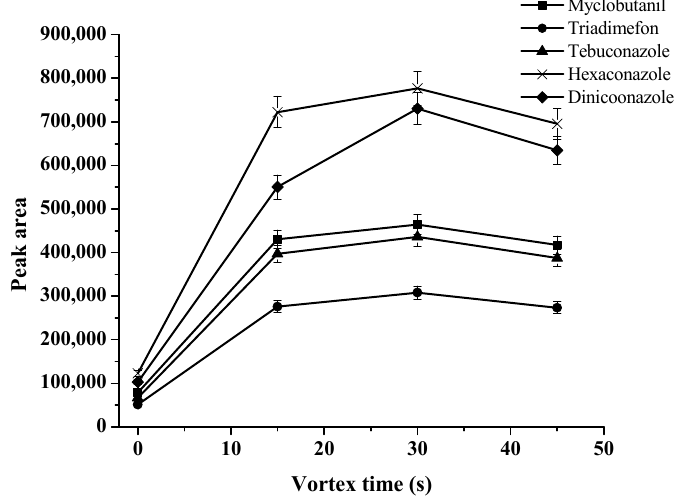
Figure 6. Effect of vortex time on extraction efficiency. The centrifugation times were studied at 0, 5, 10, and 15 min at 2500 rpm. There were no significant differences in extraction efficiency found by increasing the centrifugation time from 5 to 15 min (as can be seen in Figure 7). Incomplete phase separation was obtained at 0 min (without centrifugation). In order to minimize the extraction time, therefore, 5 min was selected as the optimum centrifugation time.